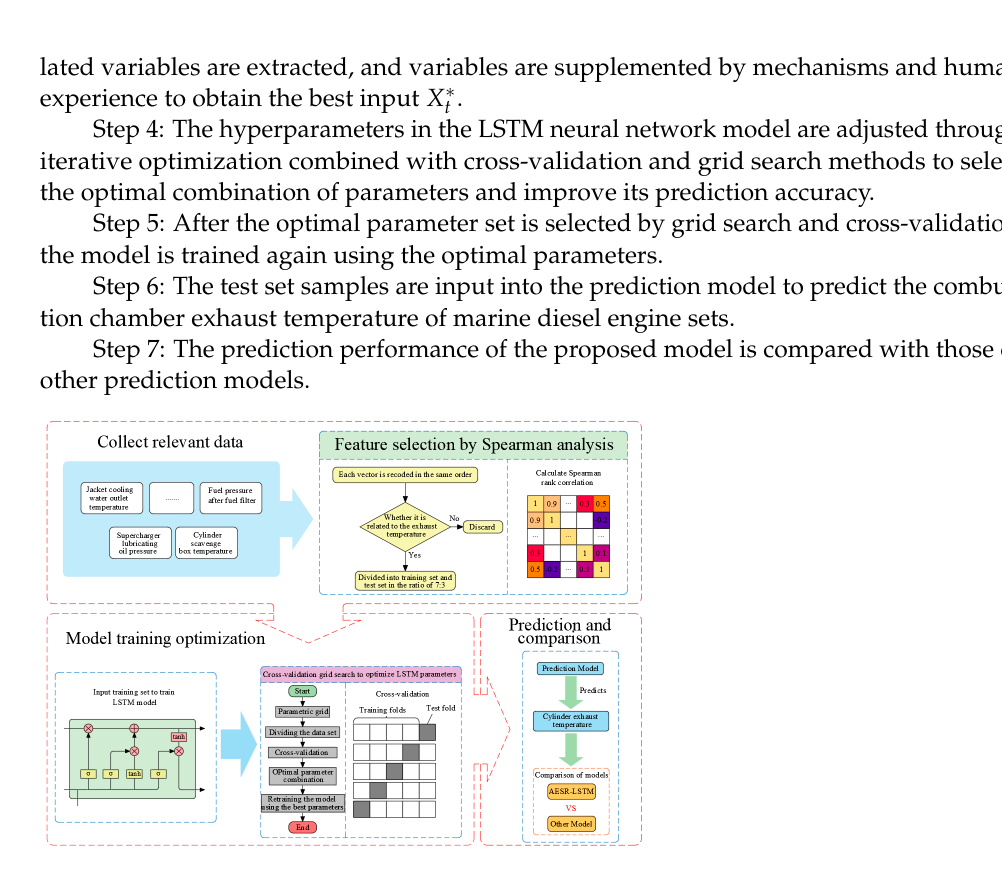
Figure 2. General Framework Structure. Algorithm 1 Partial